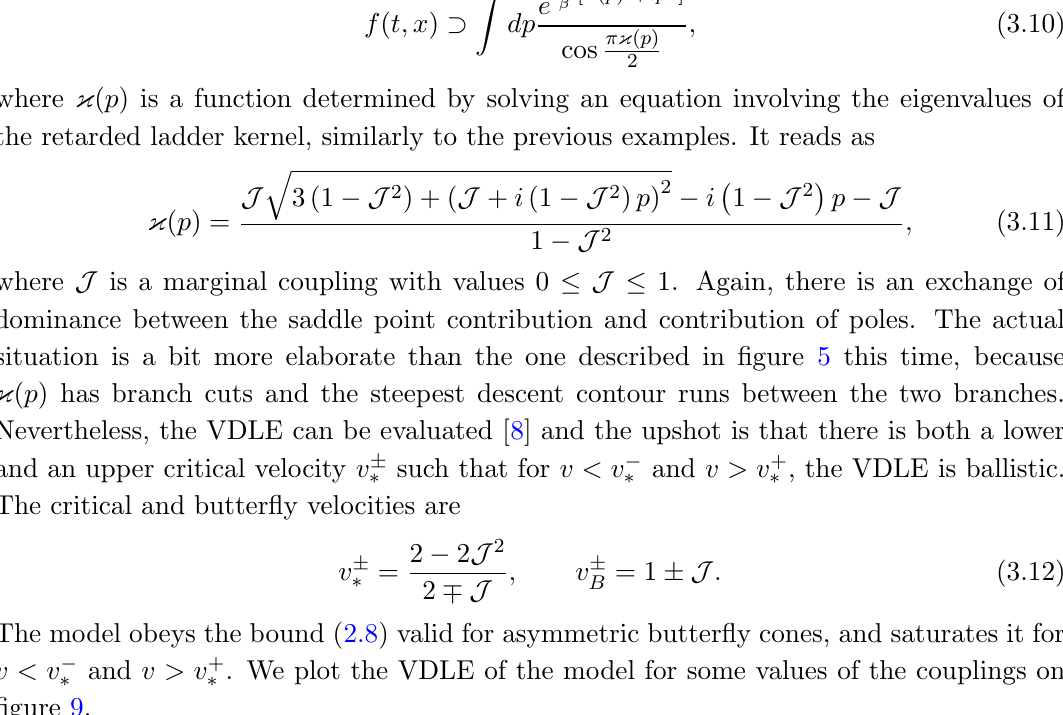
and v (cid:0) . B B